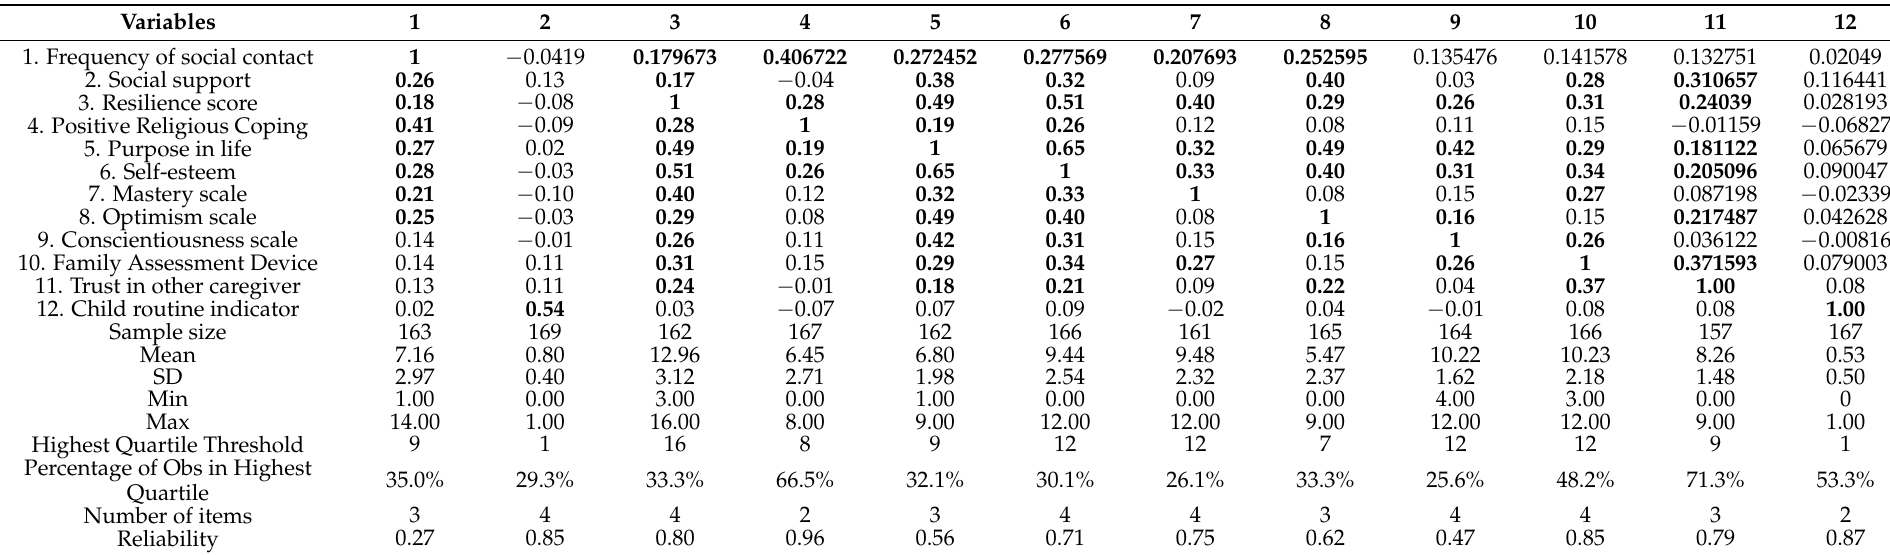
Table A2. Correlation and Descriptive Statistics for Resources Measures, original data (prior to multiple